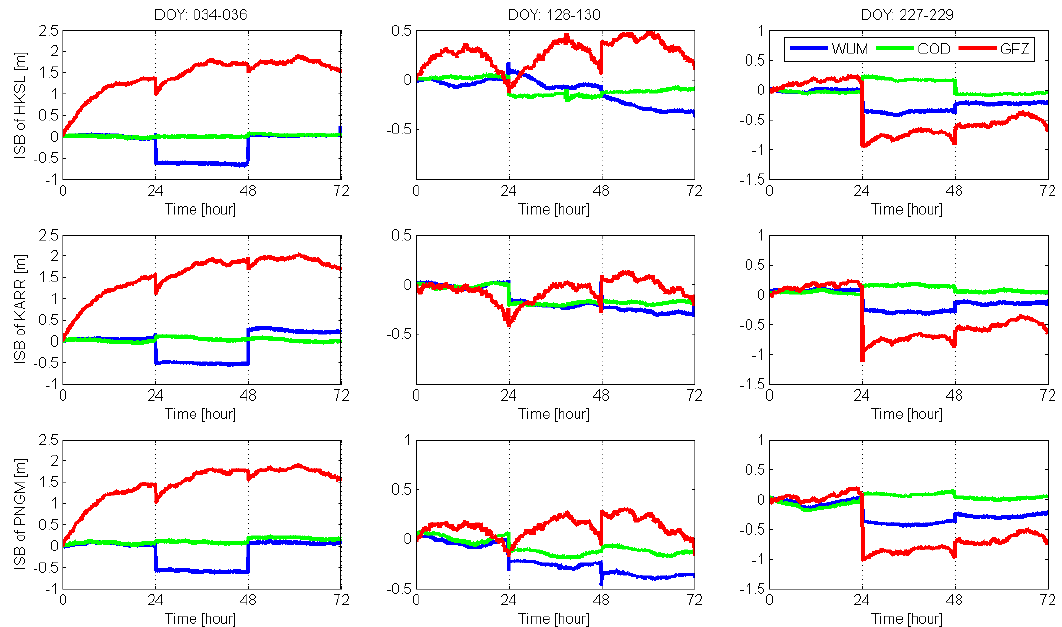
Figure 2. GPS / BDS ISB series from stations HKSL, KARR and PNGM stations estimated by using Wuhan University (WHU), Center for Orbit Determination (CODE) and Deutsches GeoForschungsZentrum (GFZ) precise products during DOY 043 – 036, 128 – 130 and 227 – 229, 2018.